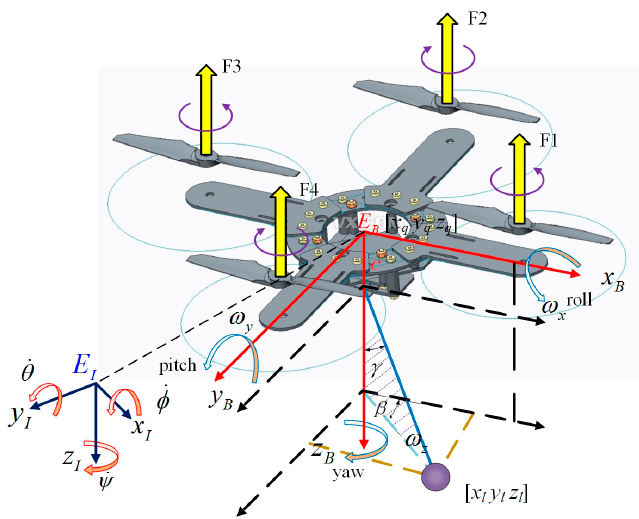
Figure 1. Quadrotor-slung load system geometry and coordinate systems.